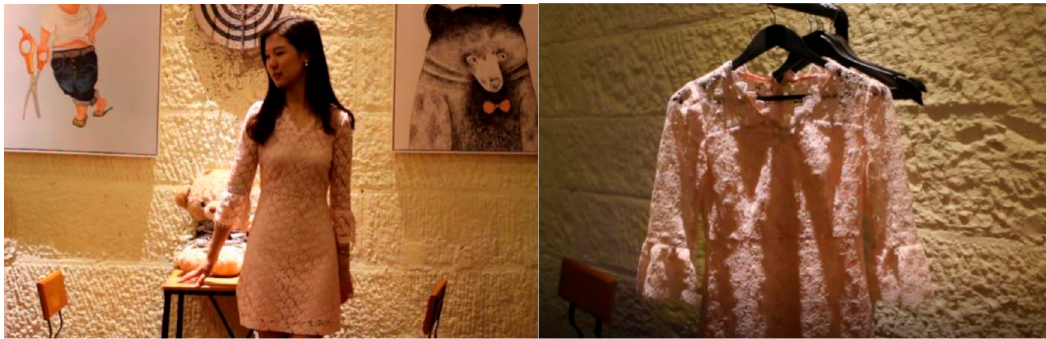
Figure 4. Images from the short video display of the product.